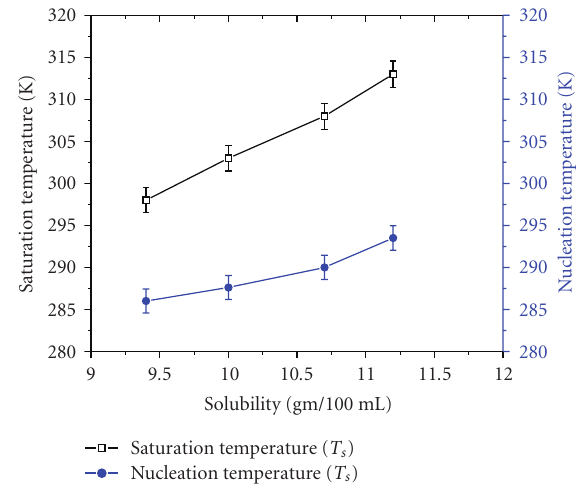
Figure 7: Solubility of L-threonine in water solvent. Figure 8: Metastable zonewidth at various saturation